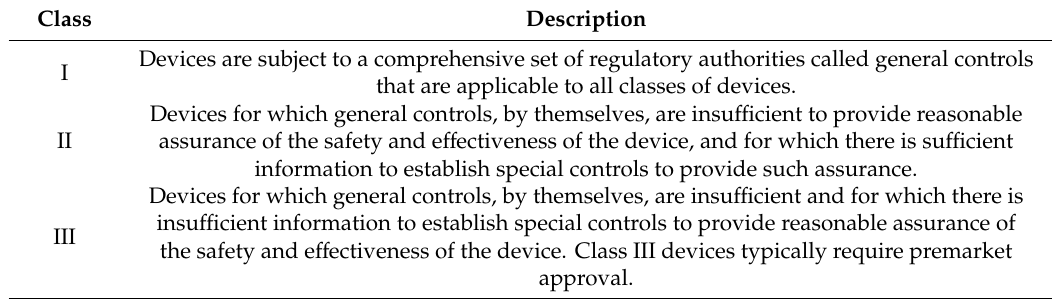
Table 4. The three groups in which devices can be classified into under Food and Drug Administration (FDA) rules